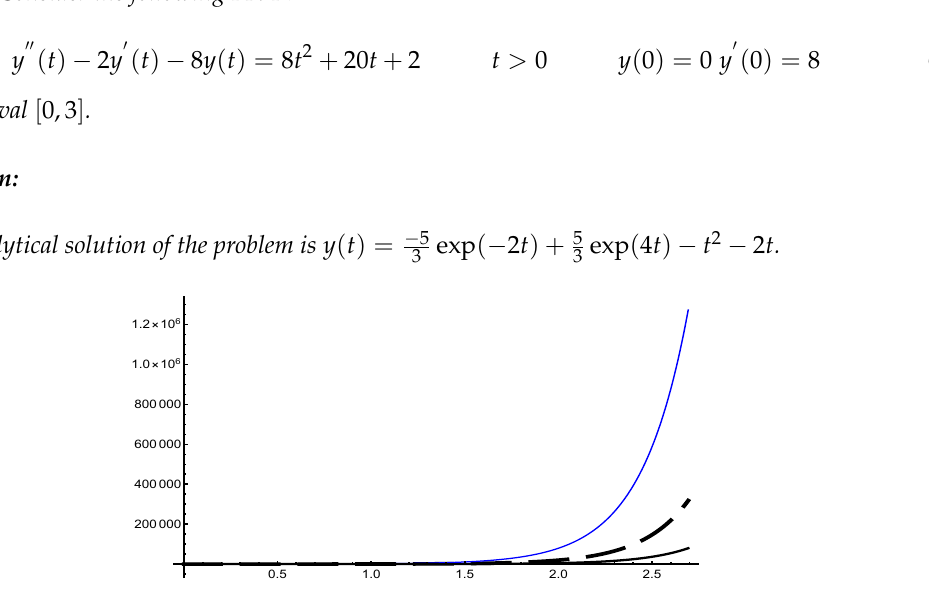
Figure 2. Graph of the function and its first and second derivatives. The black line shows the function, the dashed line shows the first derivative, and the blue line shows the second